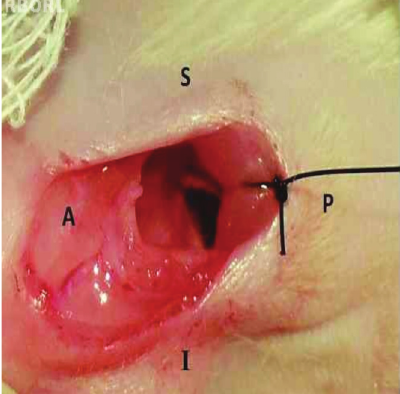
Figure 2 Exposure of the location of the tympanic bulla, deep to the cervical muscles on the left side of the rat. A, anterior; P, posterior; S, superior; I, inferior.